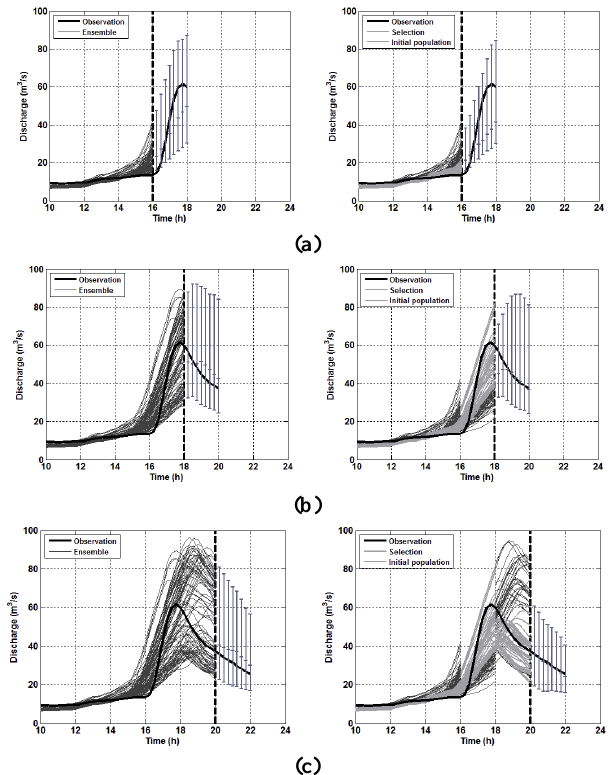
Fig. 6. Results of the forecast models for the December 2003 flood event. The vertical dashed line is the current time step. Forecasts are expressed by the median and the prediction limits for a confi- dence level of 5%. The first column shows the results of the forecast model without data assimilation and the second column the forecast model with data assimilation. The rows show forecasts by current time step: (a) t = 16h; (b) t = 18h; (c) t =